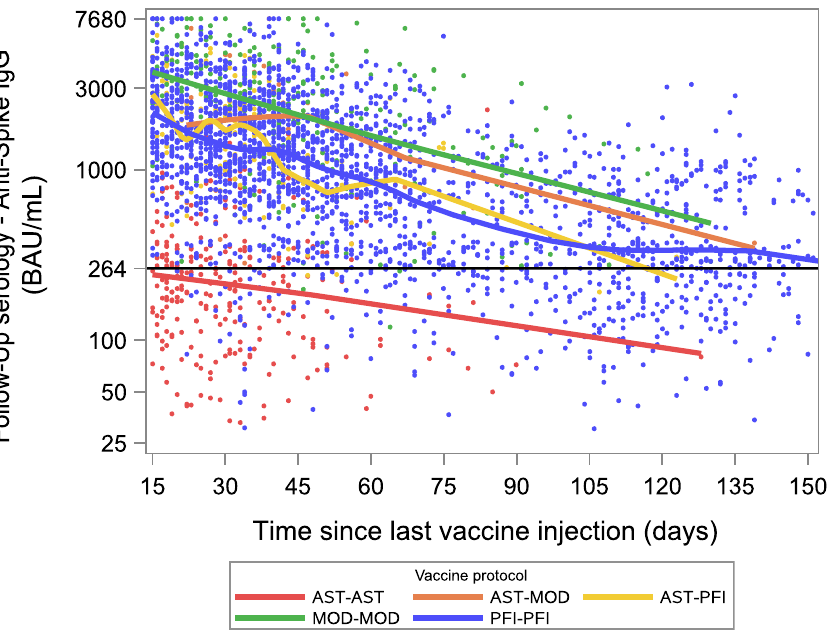
Figure 4. Scatter plot of anti-spike IgG (BAU/mL) according to time since the second vaccine dose by vaccine protocol, and locally weighted polynomial smoothing (LOESS) trend estimates. Abbreviations for first and second vaccine doses are AST = ChAdOx1 nCoV-19; MOD = mRNA-1273; PFI = BNT162b2. The dashed line at 264 BAU/mL was estimated to be associated with 80% vaccine efficacy against symptomatic infection with the Alpha (B.1.1.7) variant 9 . Seventeen samples not